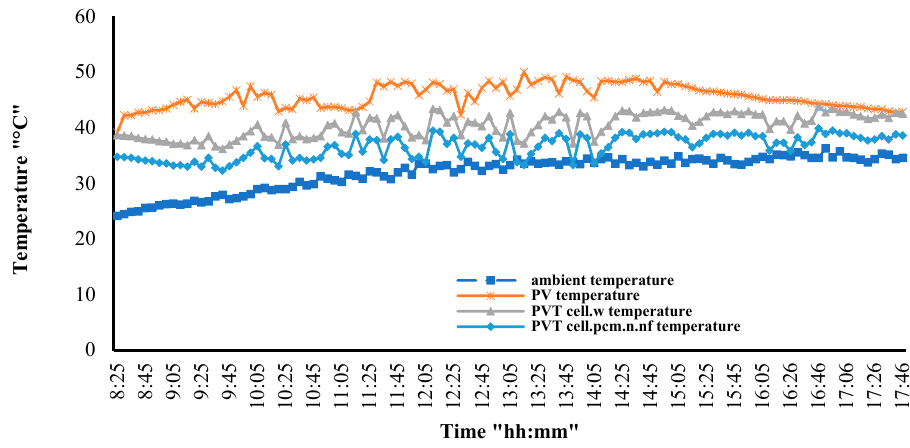
Figure 6. Cooling effect of the PV/T systems compared to the standalone PV module.